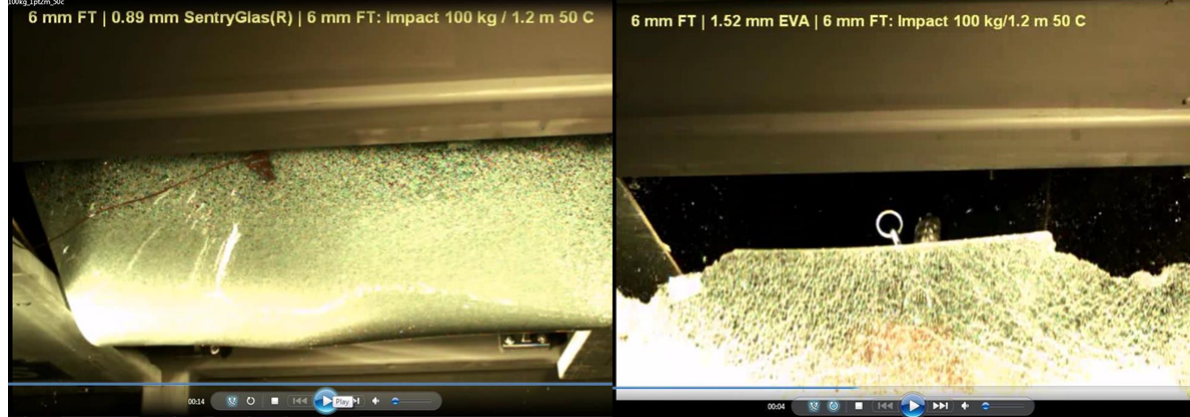
Fig. 4 EVA laminate provided no “Fall Through” resistance, view from below just after the impact, see failure of the laminate